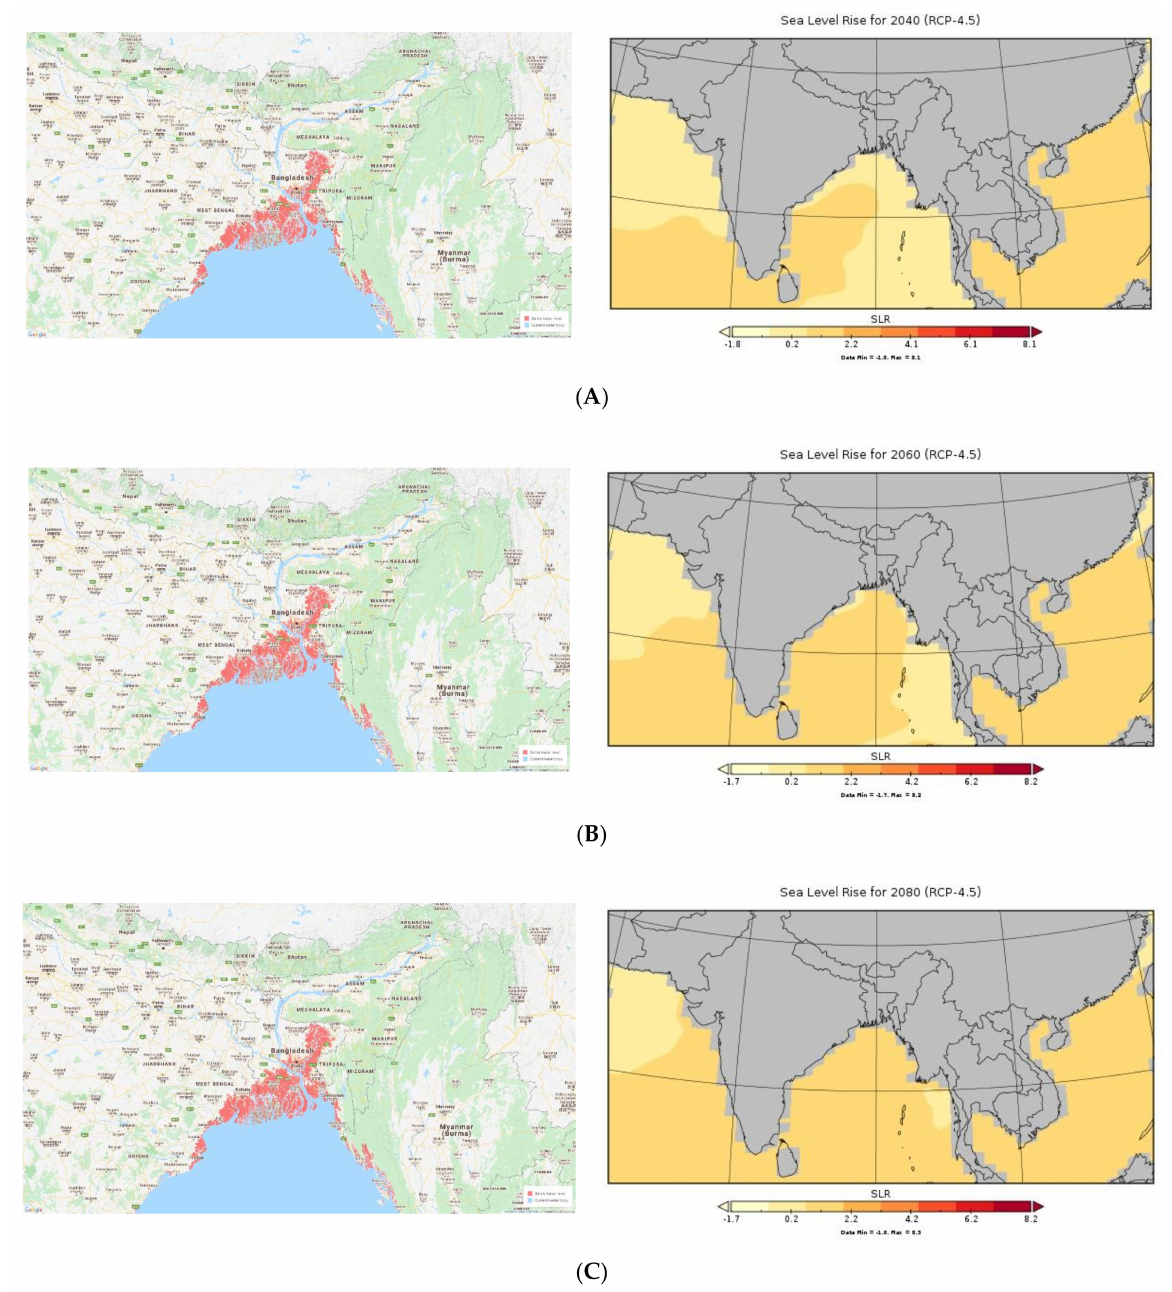
Figure 7. Projected land subsidence ( left ) and sea level rise ( right ) for 2040 ( A ), 2060 ( B ), and 2080 ( C ) over Bangladesh and Bay of Bengal using CMIP5 model’s RCP 4.5 scenario